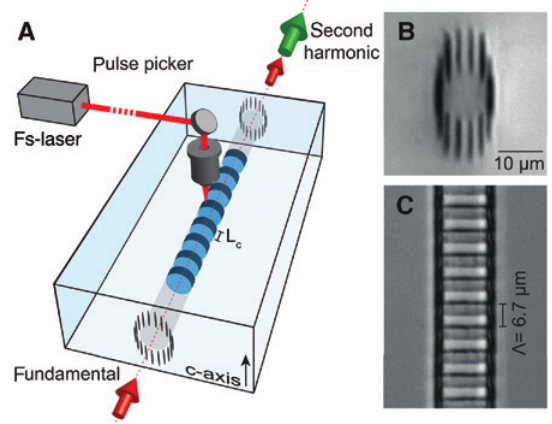
Figure 24: (A) Schematic of a QPM waveguide in z-cut lithium niobate. Optical microscope images of the (B) circular waveguide structure and (C) top view of the multiscan WBG. Reprinted with permission from [83].